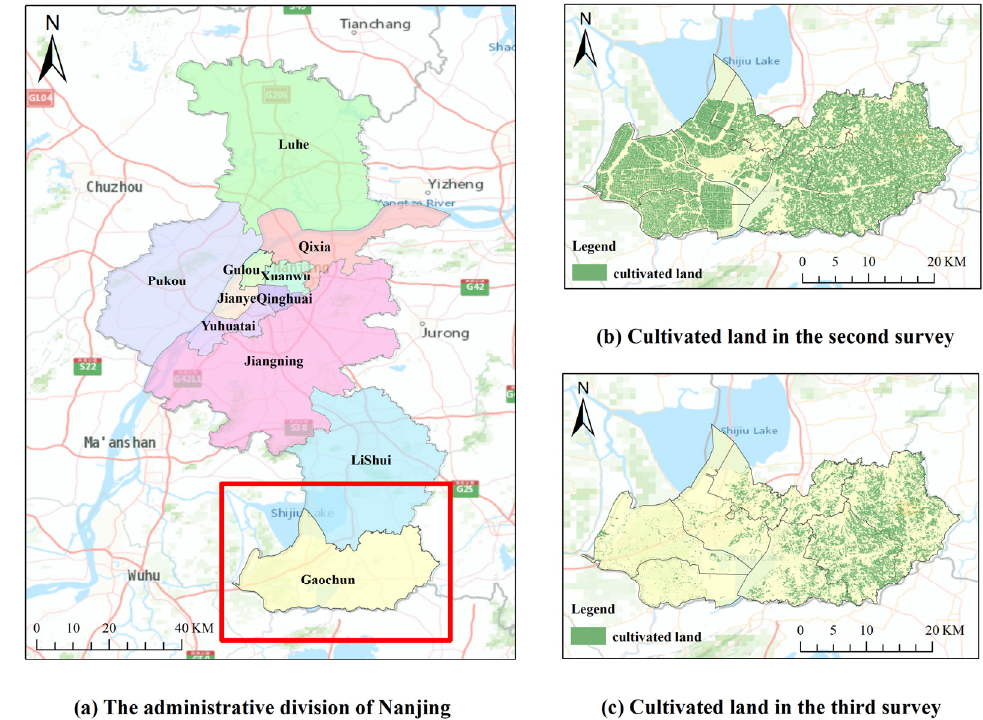
Figure 1. Overview of the research